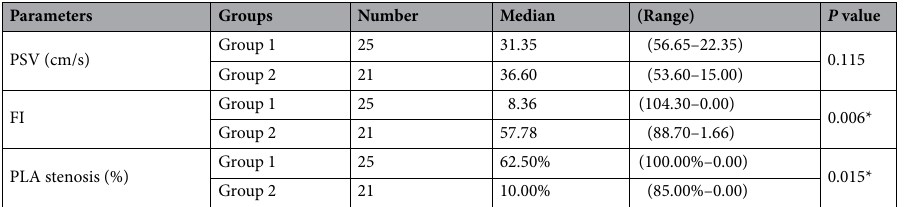
Table 3. Difference between patients with normal DUS but EHS < 3 (group 1) and patients with EHS 3–4 regardless of DUS results (group 2). Compared with patients who had EHS 3–4, patients who had normal DUS but poor EHS had a significantly lower FI and more severe PLA stenosis. EHS erection hardness score, FI flow index, IIEF-5 the simplified International Index of Erectile Function, PLA pelvic artery, PSV peak systolic velocity. Mann–Whitney U Test, * P <